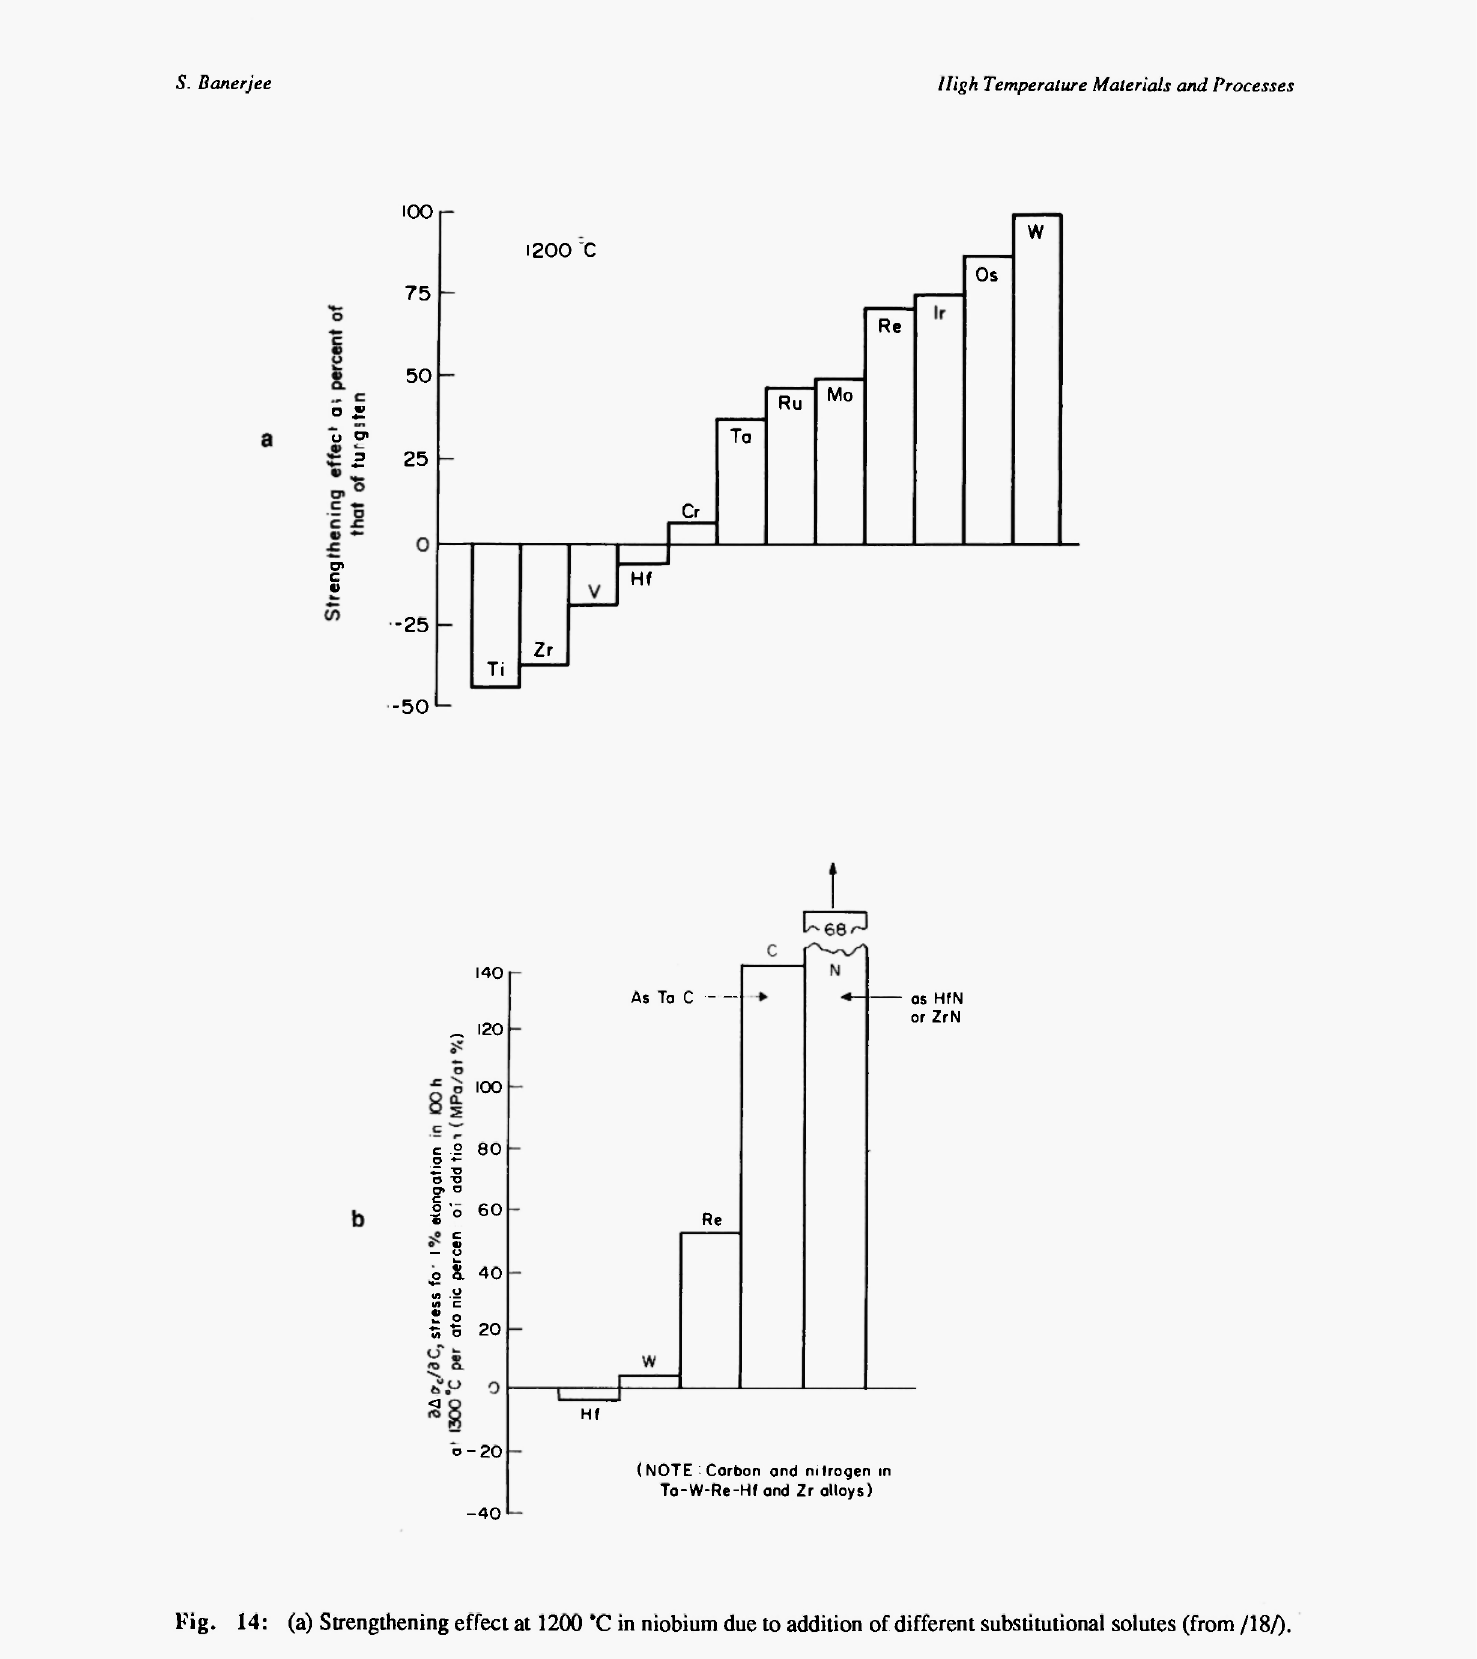
Fig. 14: (a) Strengthening effect at 1200 'C in niobium due to addition of different substitutional solutes (from